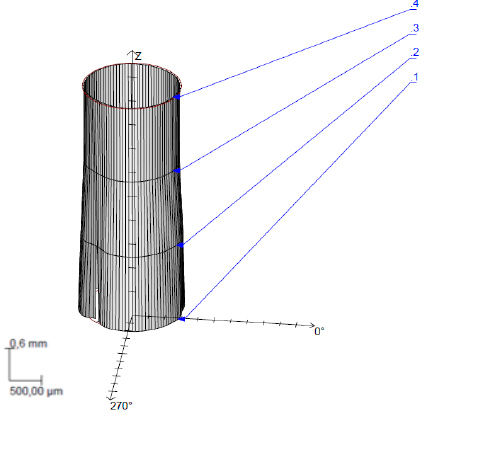
Figure 16. Cylindricity deviations. Test 11. WP = 1200 bar, TFR = 45 mm/min and AMFR = 170 gr/min for: ( a ) UNS A97075/CFRP configuration; ( b ) CFRP/UNS A97075 configuration.